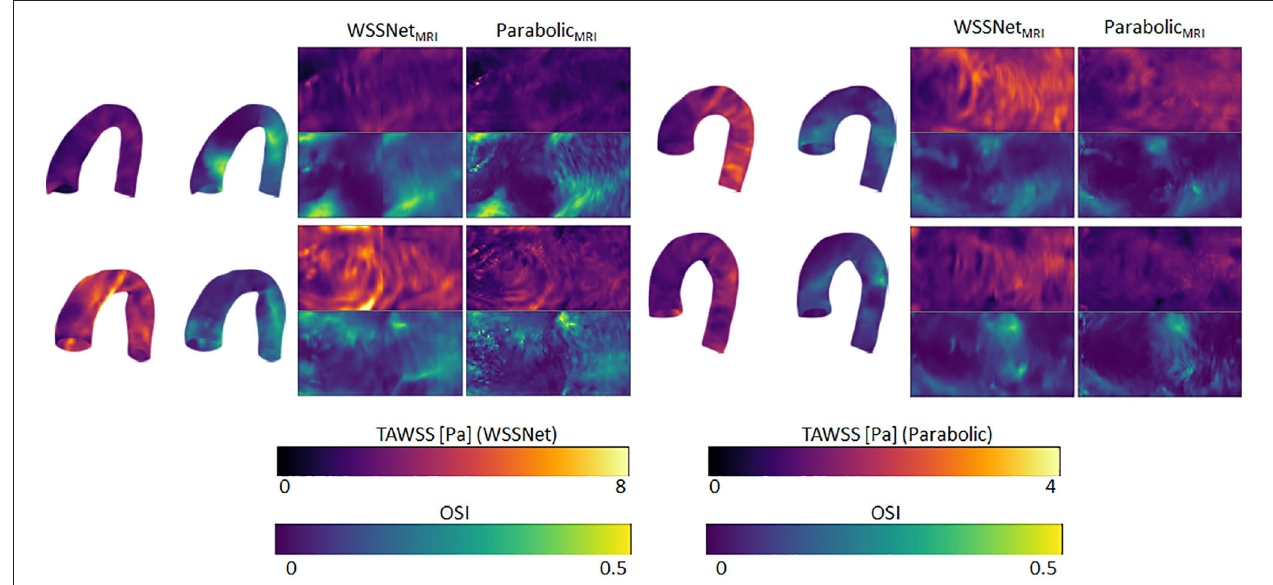
FIGURE 12 | Time-averaged WSS and OSI comparison between WSSNet and parabolic fitting method in 4 cases of in vivo 4D Flow MRI. TAWSS derived from the parabolic method were much lower and shown using different dynamic ranges (0–4Pa) to highlight pattern similarity between methods 3D representations of the TAWSS and OSI from WSSNet are shown on the left side of each